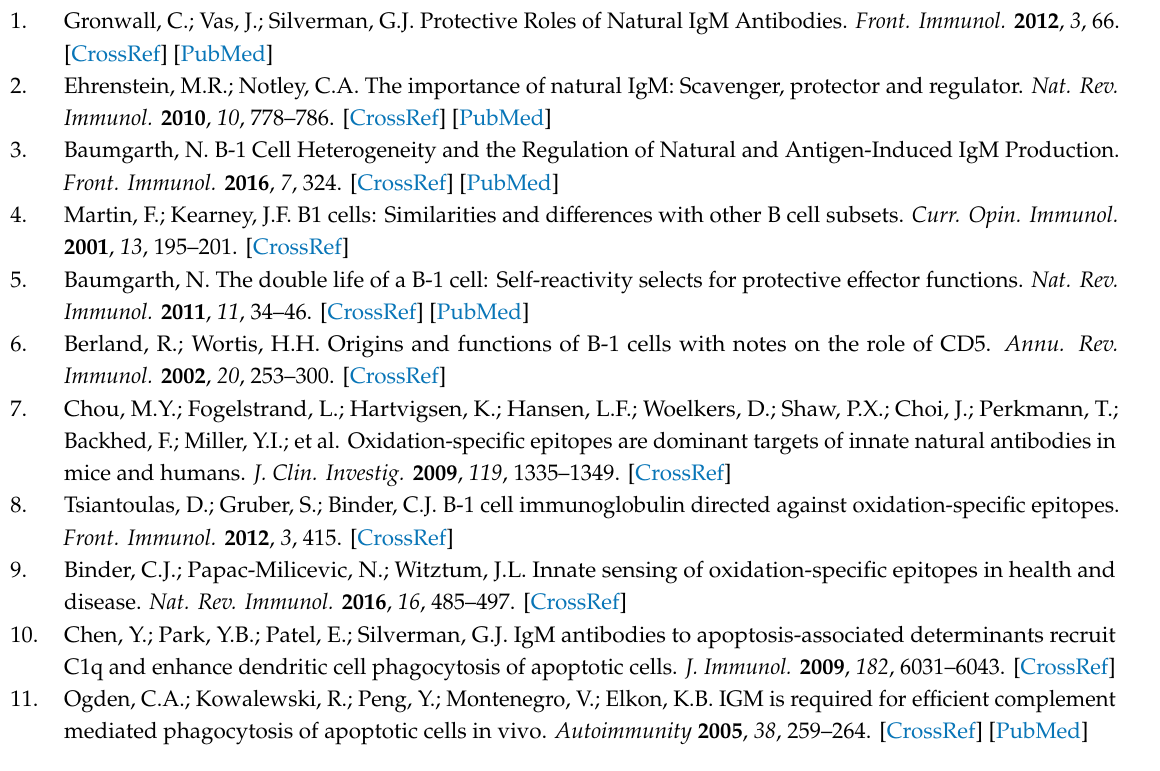
Figure S1: Representative ELISPOT assays, Figure S2: E06 mRNA levels in spleen of female Cd1d − / − Ldlr − / − mice, Figure S3: Neither T cells nor T reg cells are decreased in the spleen of Cd1d − / − Ldlr − / −